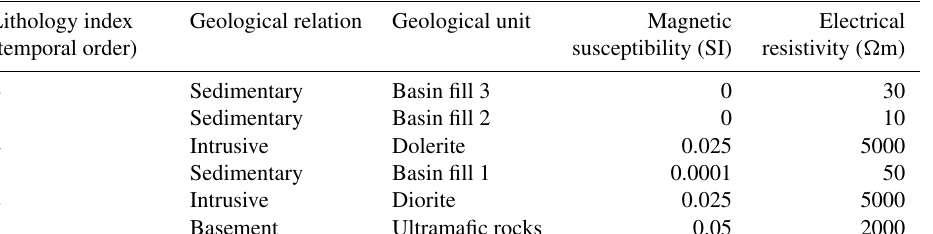
Table 1. Stratigraphic column showing geological topological relationships and average physical properties. Lithologies are indexed from 1 through 6 by order of genesis.